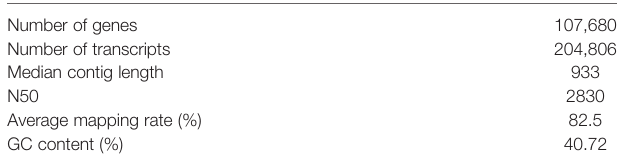
TABLE 2 | Basic de novo transcriptome statistics for S. thompsoni . Number of genes